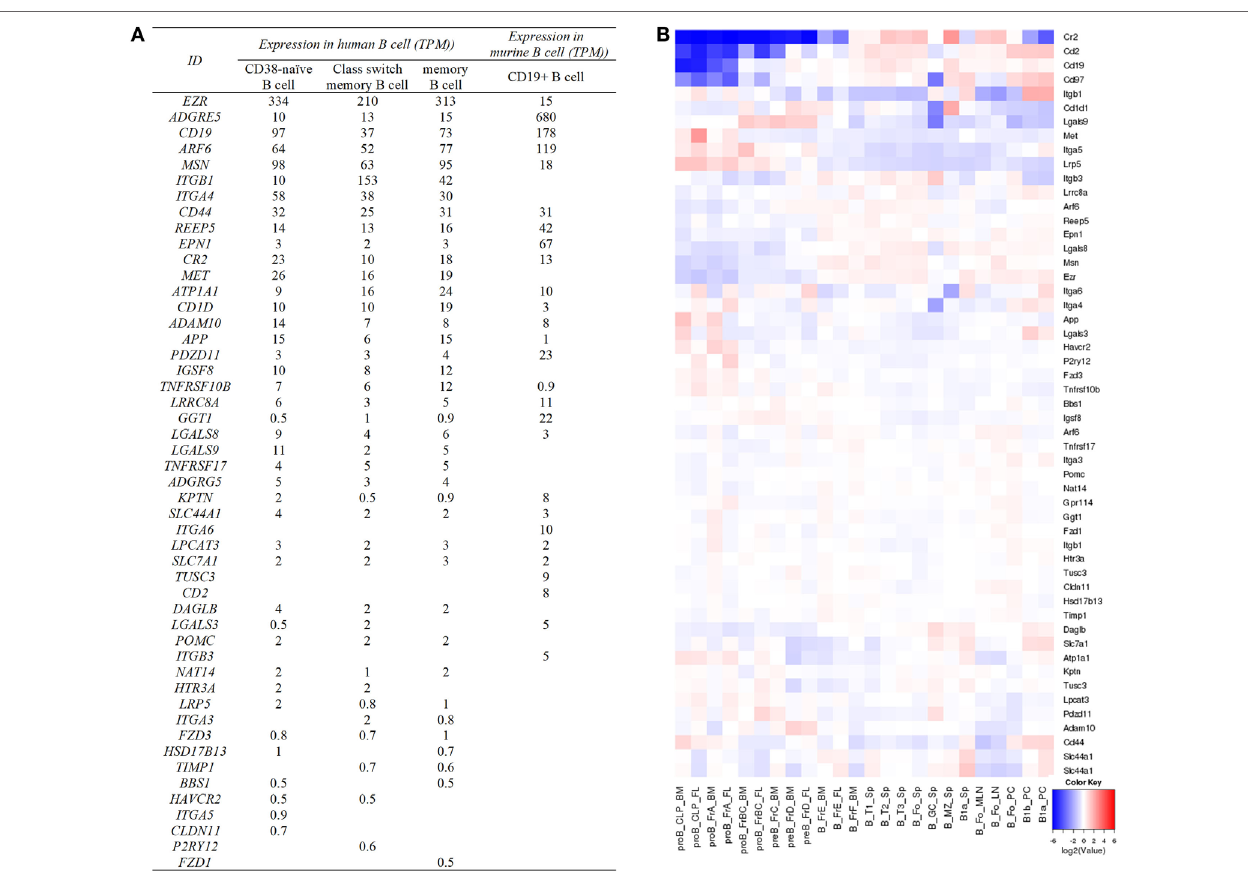
FiGURe 5 | Expression of tetraspanin partners in human and murine B cell subsets. (A) The expression of cell surface partners of human and murine tetraspanins on specific B cells. The partners without TPM values are not listed in the table. Human data are determined by the RNA-seq data generated by the Blueprint Consortium, and murine data are from RNA-Seq CAGE (Cap Analysis of Gene Expression) analysis of mouse cells in RIKEN FANTOM5 project. (B) Expression of tetraspanin partners listed in (A) in murine B cell subsets. The heat map was obtained from http://www.immgen.org/ by inputting the list of cell surface partners of tetraspanin partners in “My GeneSet” and choosing B cells as the populations of interest. Based on the database, ADGRE5, ADGRG5, and CD1D in (A) are shown as Cd97, Gpr114, and Cd1d1 in (B) ,